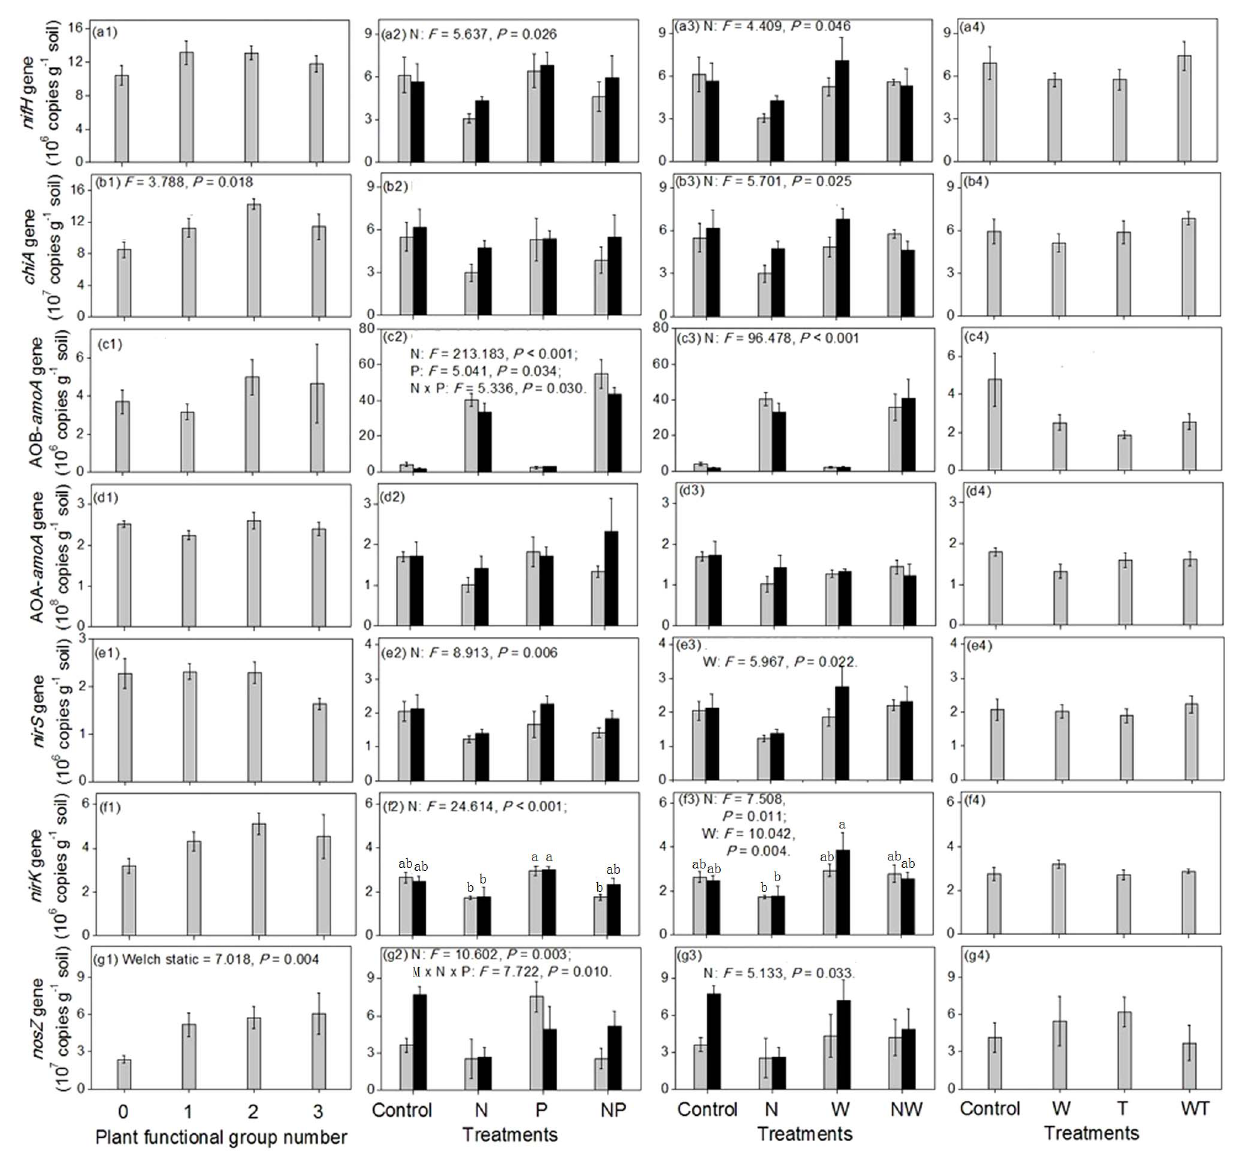
Figure 2. Effects of different treatments on the abundances of seven N-cycling genes. Error bars represent one standard error. For clarity, only the statistical results with P , 0.05 are shown. 0, 1, 2 and 3 for the x axis in a1–g1 represent the remained PFG number. M, N, P, W and T represent the same treatments as Figure 1. In a2–g2 and a3–g3, gray and black columns represent the treatments without and with mowing, respectively. There are 5, 4, 4 and 6 replicates for a1–g1, a2–g2, a3–g3 and a4–g4,